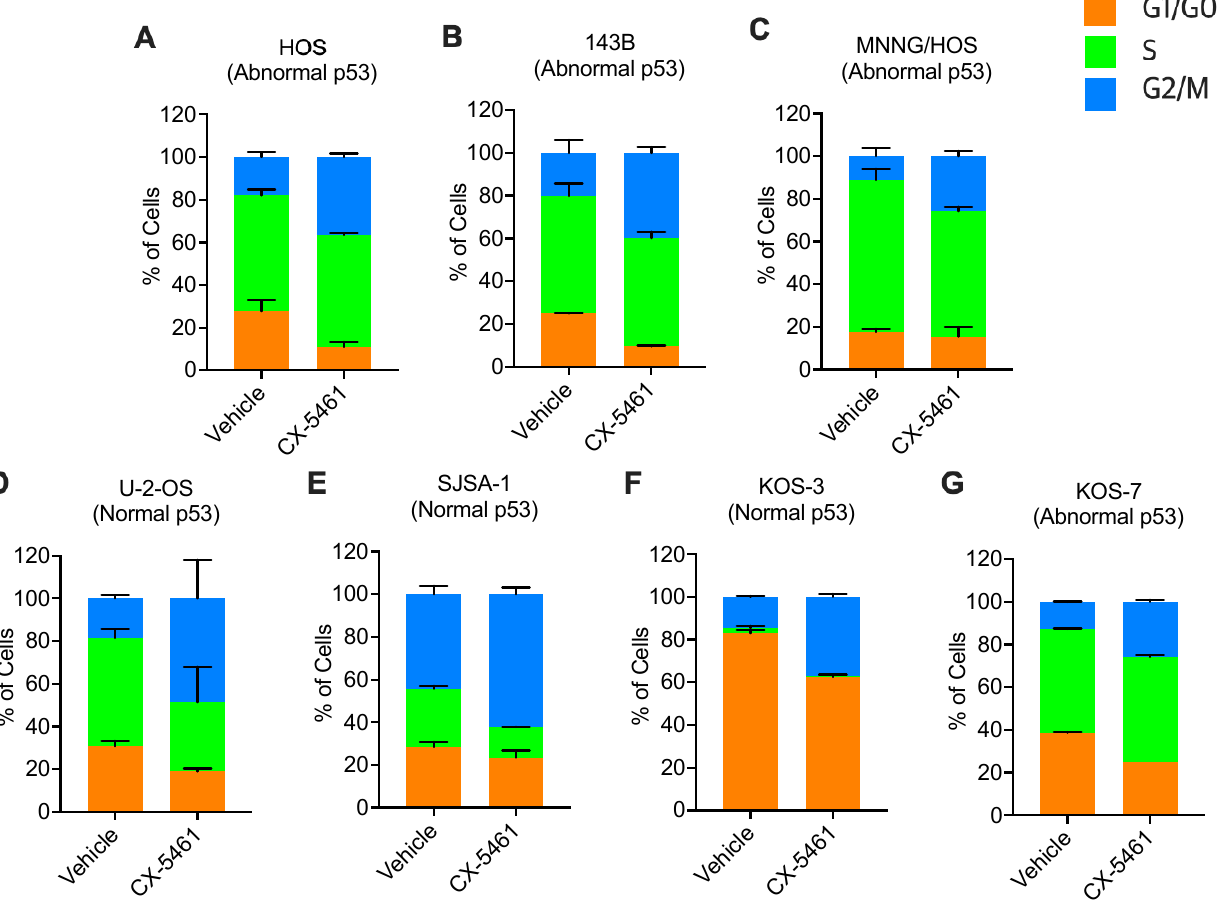
Figure 3. CX-5461 induces G2-phase cell cycle arrest in human OS cells. ( A – G ) ATCC and KOS osteosarcoma cell lines were treated with the respective GIC 50 CX-5461 dose (determined from Figure 2) or vehicle (50 mM NaH 2 PO 4 (pH4.5)) for 72 h, and the proportion of cells in each cell cycle phase was determined using BrdU/PI staining and flow cytometric analysis. Mean +/ − SD of n = 2 biological replicates. G1/G0 = quiescent and growth phases not involving proliferation; S = DNA synthesis phase; and G2/M = growth and preparation for mitosis and mitosis phases.